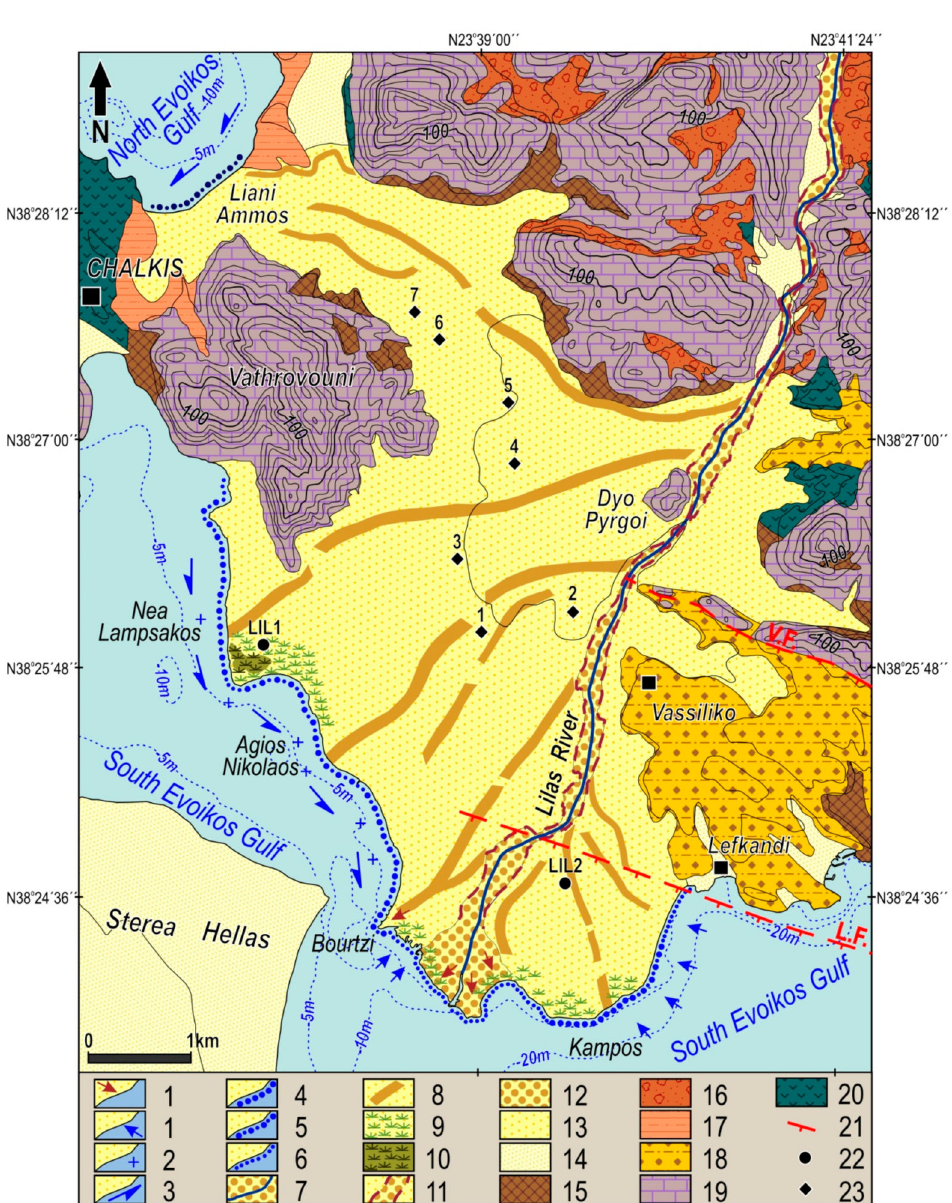
Figure 3. Geomorphological map of the Lilas River fan delta. Legend: 1: